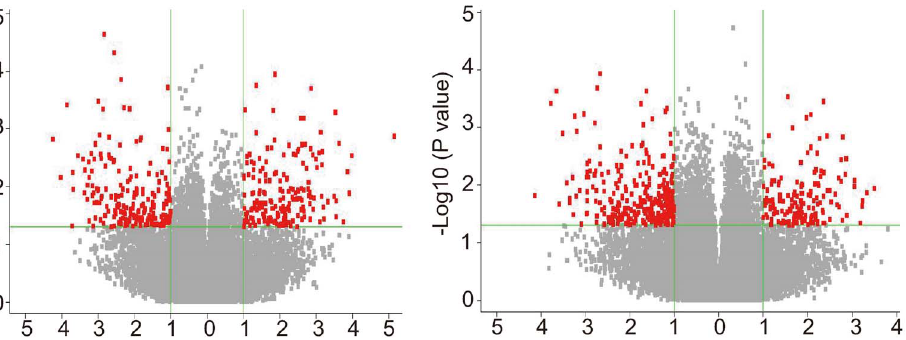
Figure 2. Volcano plot of stretching vs. control at 1 and 24 h. Each point represents a gene plotted as a function of fold change (Log2(fold change), x-axis) and statistical significance (-Log10(p-value), y-axis). The vertical dotted line represents twofold changes. The horizontal dotted line represents p=0.05. The red dots represent selected differentially expressed genes with p , 0.05 and more than twofold change.